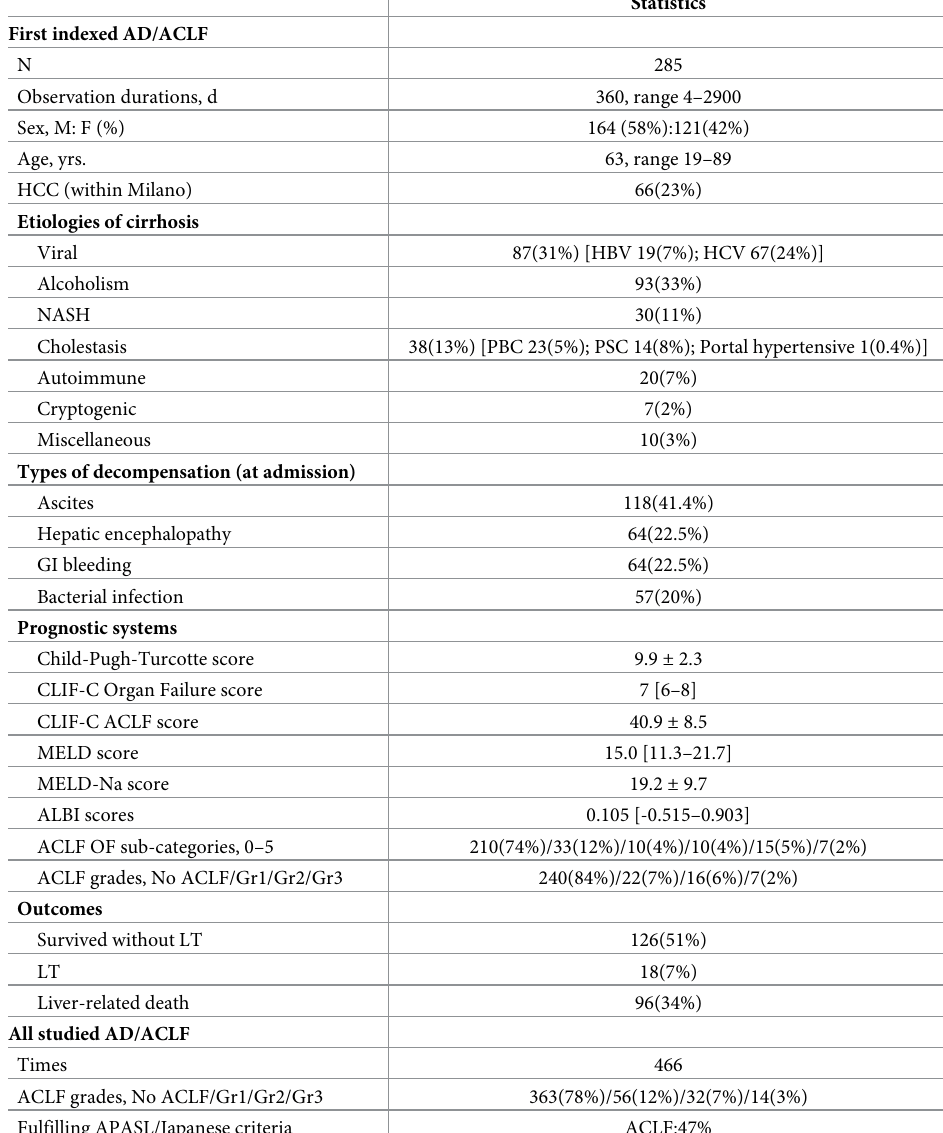
Table 1. Background characteristics, prognostic systems, and outcomes of included study